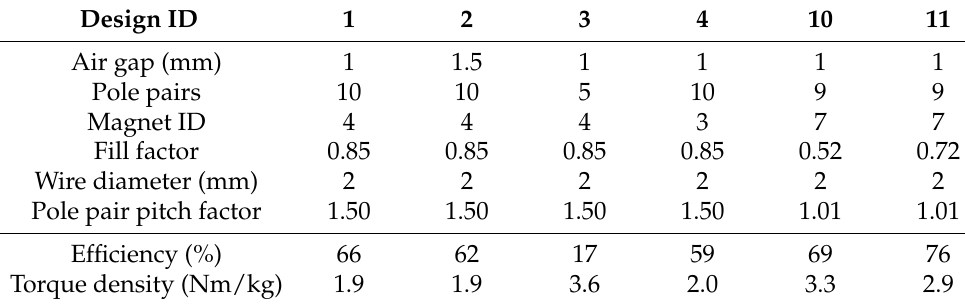
Table 6. Designs 1–4 (by-hand) and 10–11